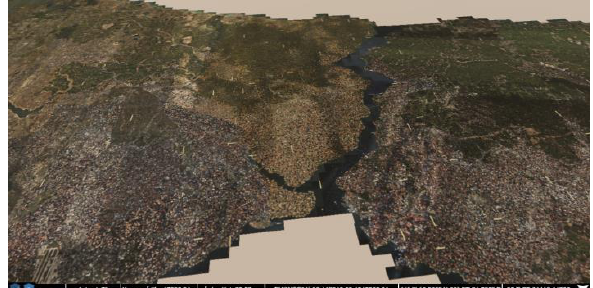
Figure 3. Istanbul province as the first project (estimating solar energy) study area.